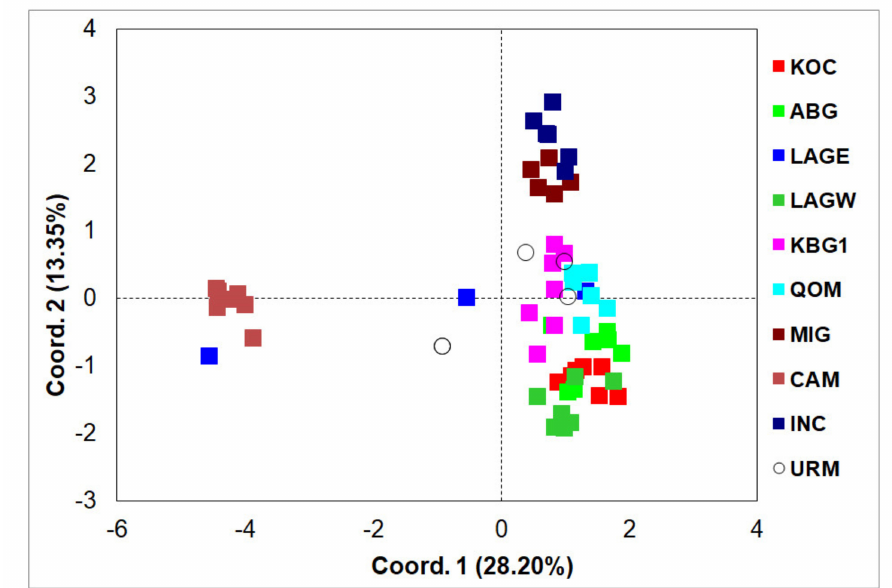
Figure 9. Principal Coordinates Analysis (PCoA) showing di ff erentiation patterns among native populations based on ISSR markers (abbreviations listed in Table 1).